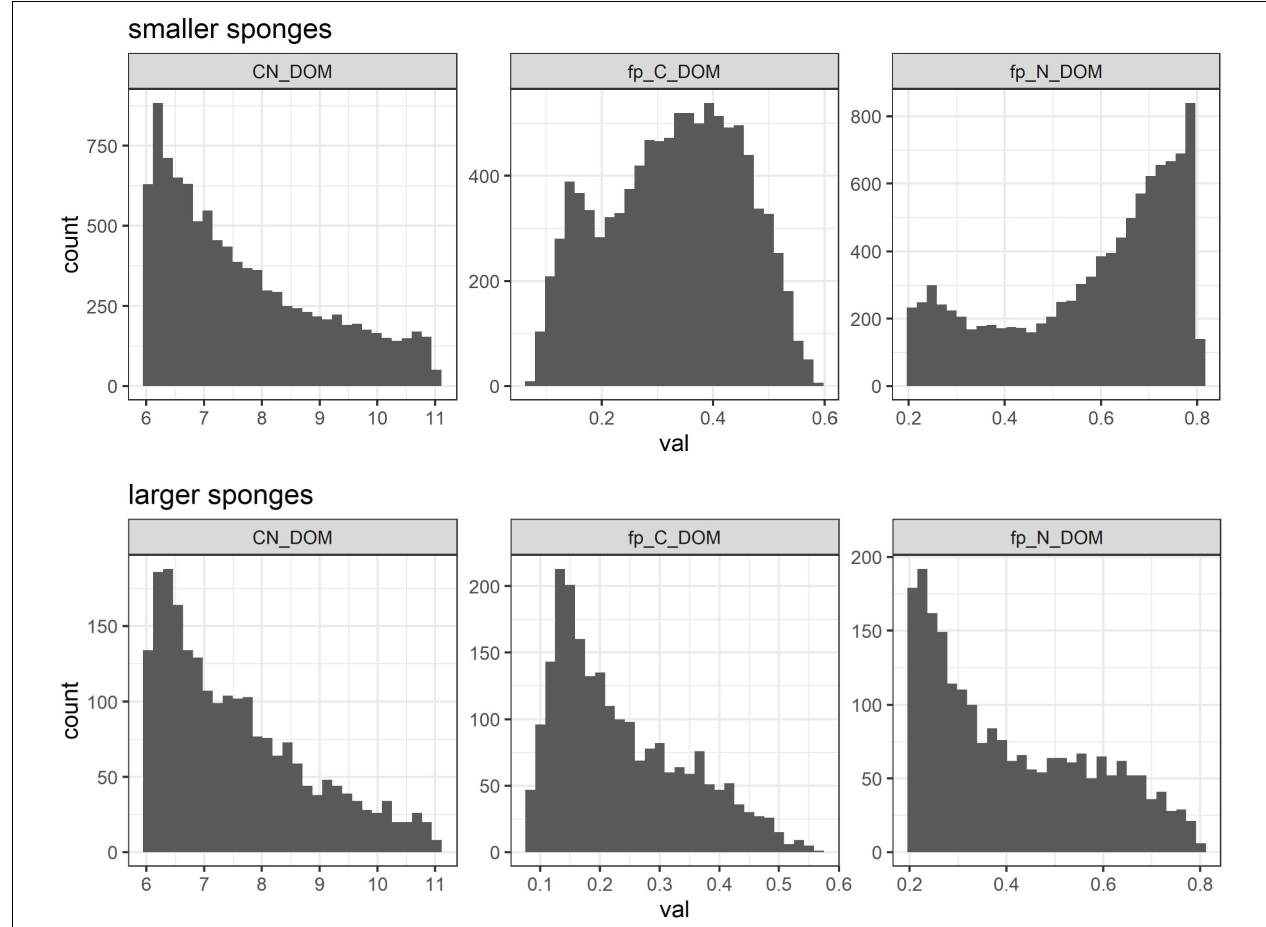
FIGURE 5 | Distribution of coefficients in reaction 2 [(DOM) assimilation and aerobic respiration] to produce feasible model solutions: stoichiometry (C:N) of DOM (left) and C (middle) and N (right) production efficiencies in smaller (top) and larger (bottom) Geodia